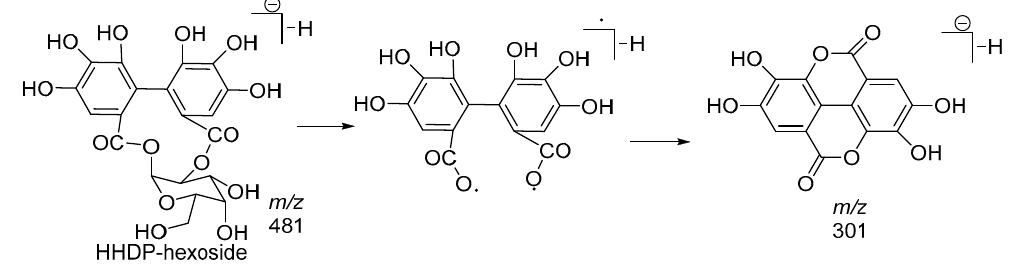
Figure 8. Fragmentation pathway of HHDP-hexoside.